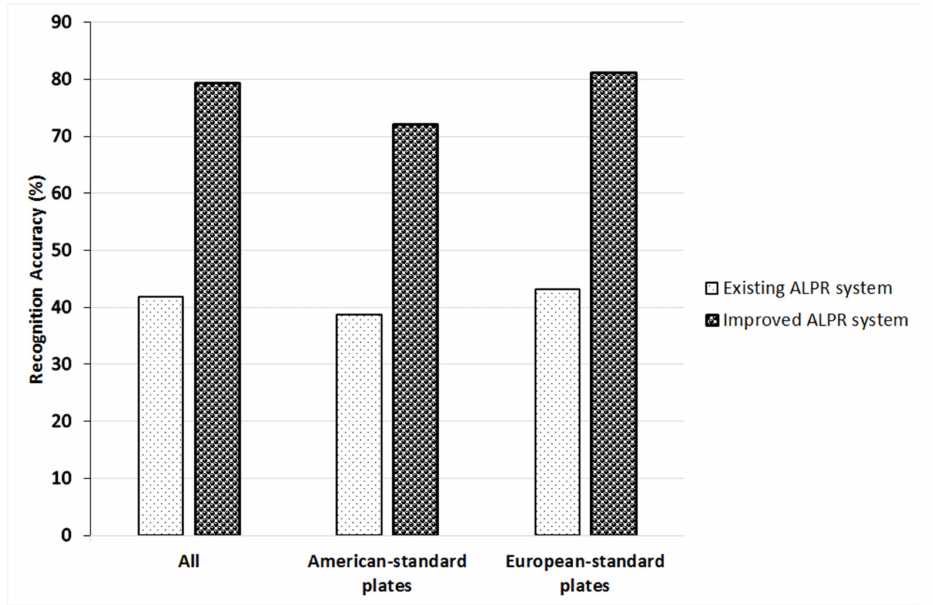
Figure 8. Comparison between the accuracy of the Existing and Improved ALPR systems.